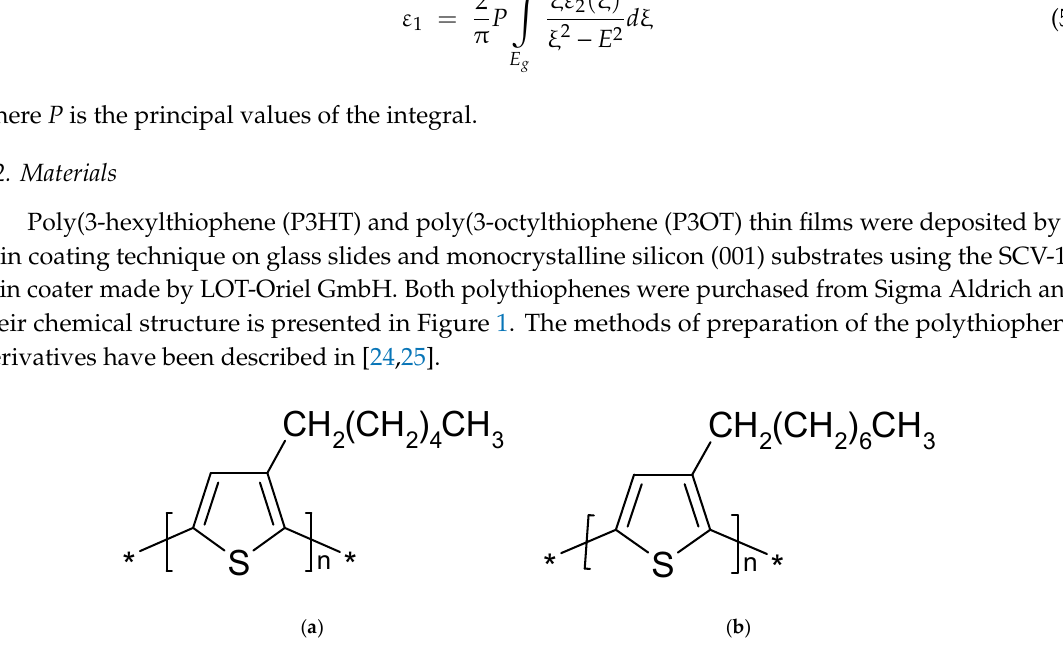
Figure 1. Chemical structure of ( a ) poly(3-hexylthiophene (P3HT), ( b ) poly(3-octylthiophene (P3OT).